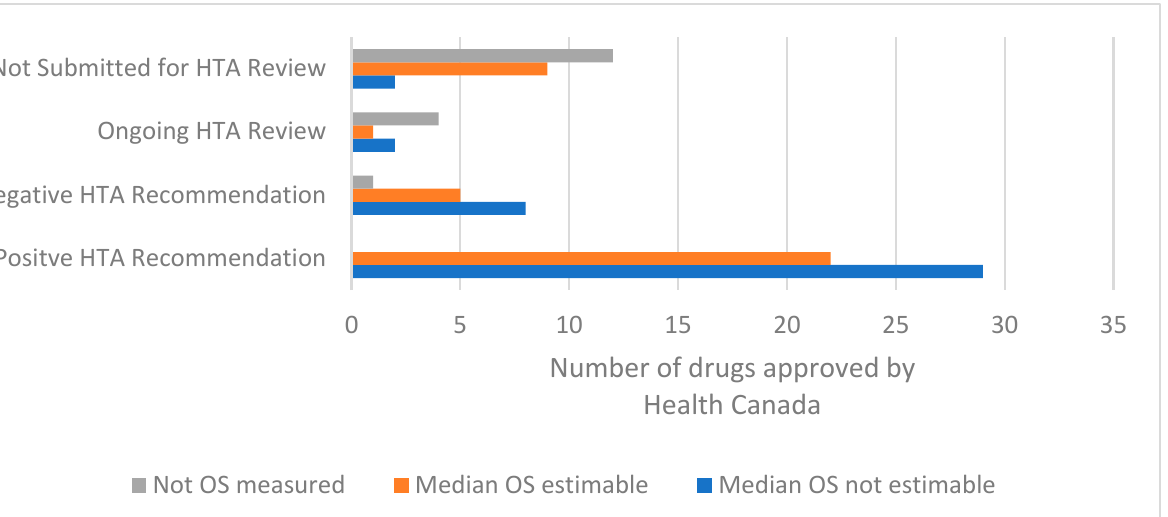
Figure 6. Availability of median overall survival results at the time of the HTA recommendation for drugs for solid tumour indications approved by Health Canada from 1 January 2017 to 31 October 2021. Abbreviations: HTA, health technology assessment; OS, overall